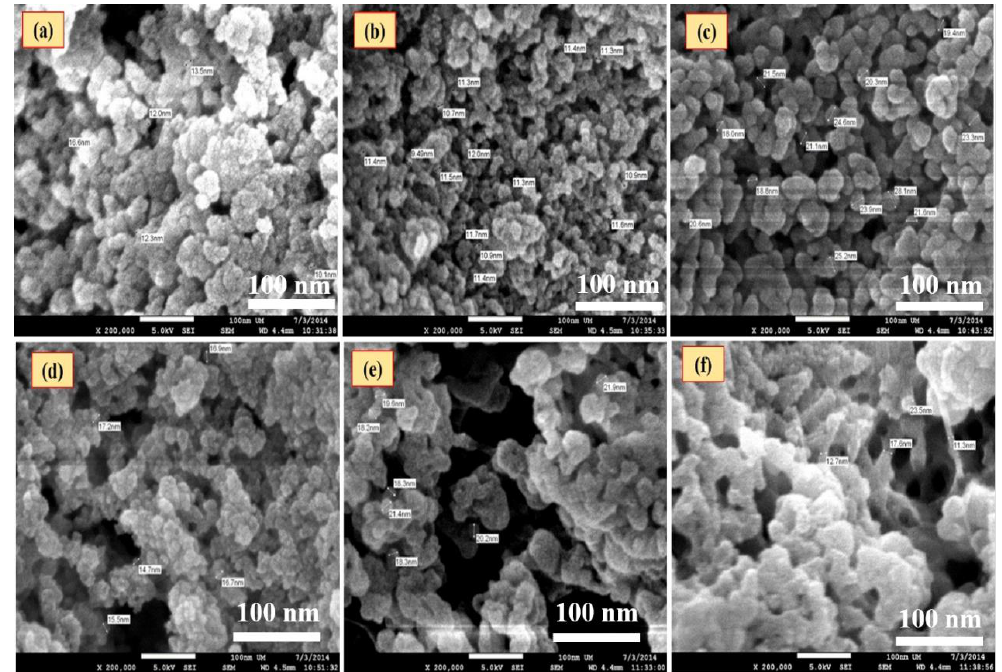
Figure 10. FESEM micrographs of PPVA-AlPO 4 nanocomposite samples formed from different pH of ( a ) 7; ( b ) 8; ( c ) 9; ( d ) 10; ( e ) 11 and ( f ) 12 at 200 k magnification.